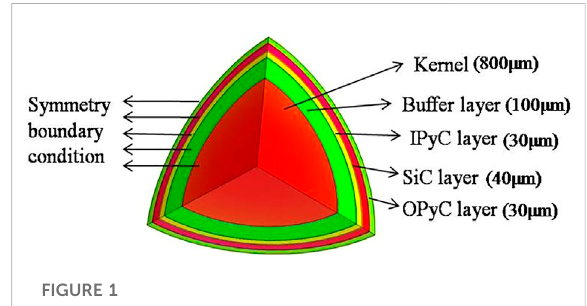
FIGURE 1 Schematic diagram of a characteristic TRISO